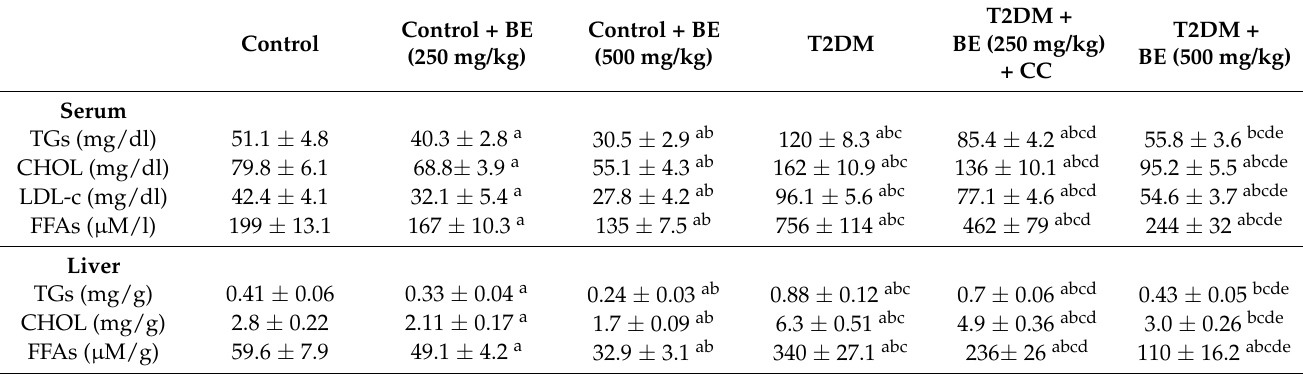
Table 3. Lipid profiles in the serum and livers of all groups of rats.